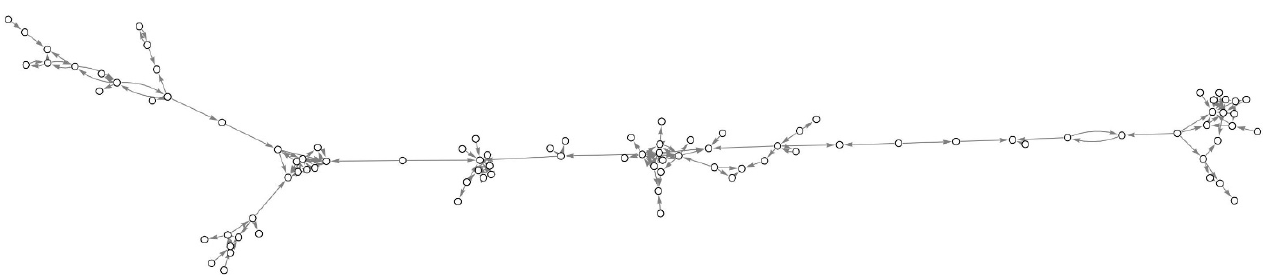
Figure 10. Supply Chain for 34 days from 1st June 2021. Largest component only. Standard member and chama nodes only.